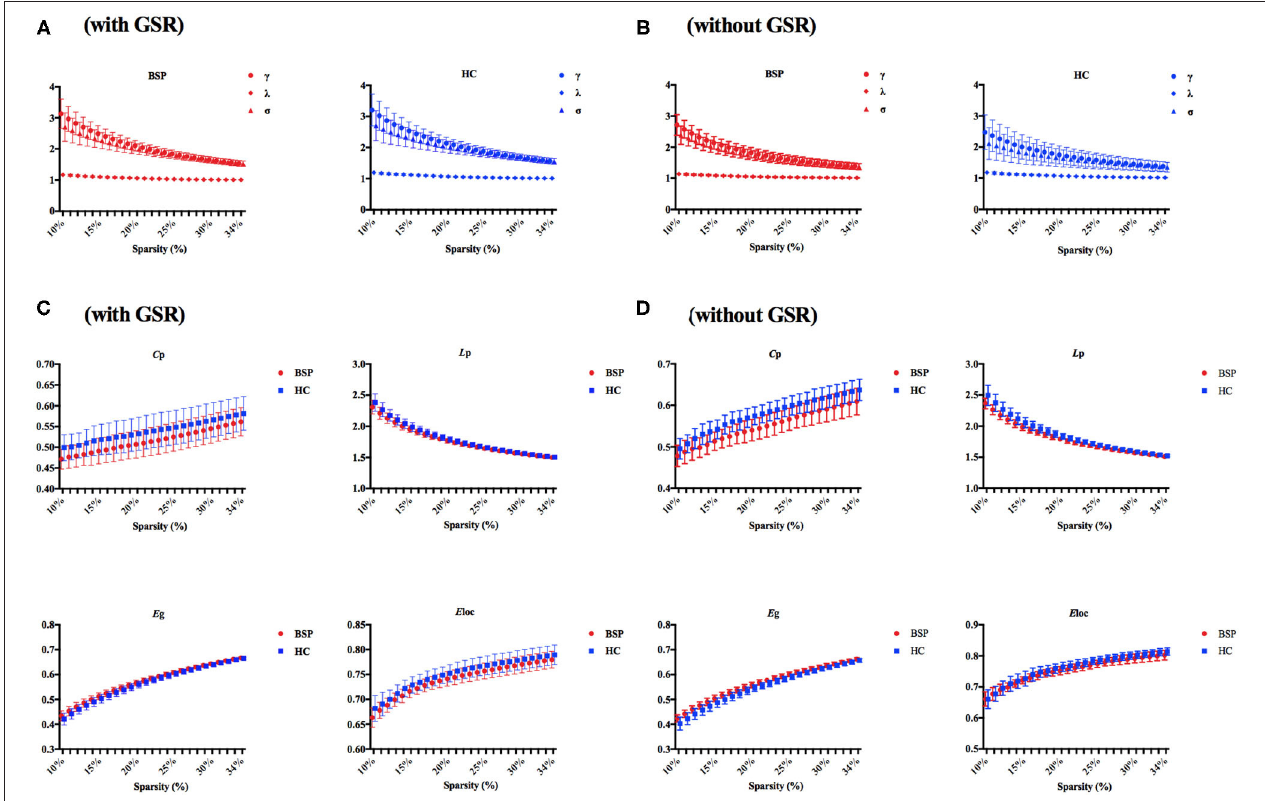
FIGURE 1 | (A) Small-world properties in patients with BSP and HCs (with GSR); (B) small-world properties in patients with BSP and HCs (without GSR); (C) global topographic properties in BSP and HC groups with over the selected range of the sparsity threshold (with GSR); (D) global topographic properties in BSP and HC groups with over the selected range of the sparsity threshold (without GSR). BSP, blepharospasm; C p , clustering coefficient; E glob , global efficiency; E loc , local efficiency; GSR, global signal regression; HC, healthy control; L p , characteristic path length.